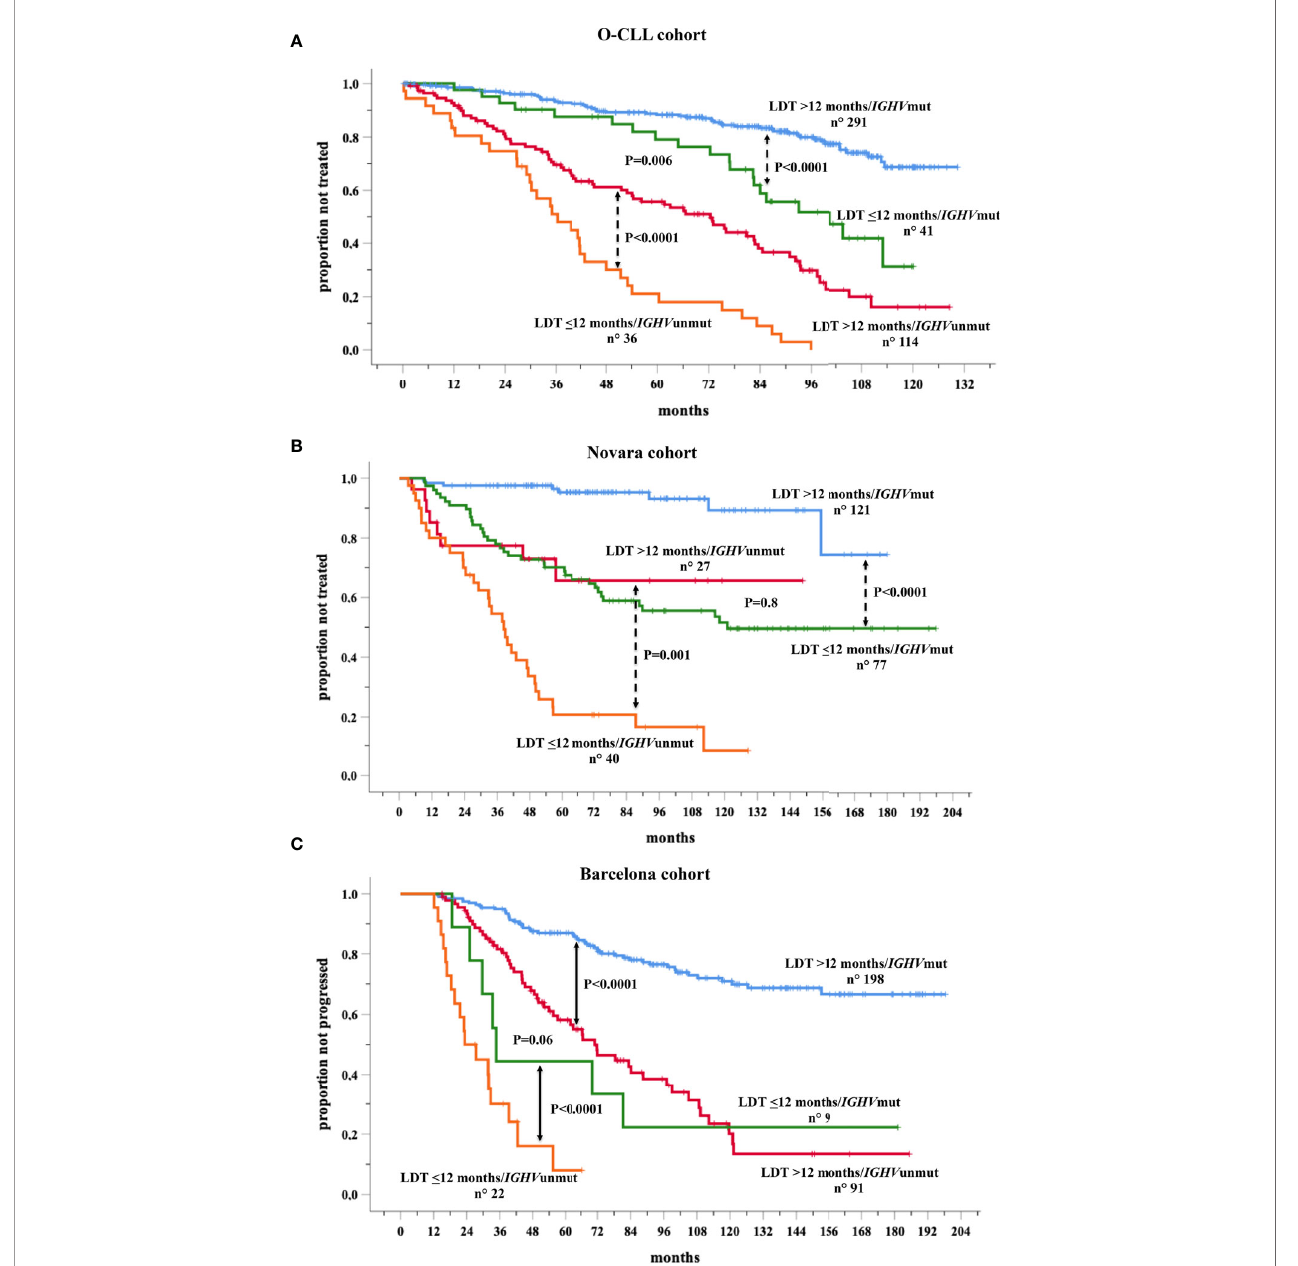
FIGURE 5 | Kaplan-Meir curves of time to fi rst treatment (TTFT) of patients strati fi ed by the combined analysis of lymphocyte doubling time (LDT) and IGHV mutational status in the O-CLL training cohort (A) and Novara (B) and Barcelona (C) validation cohorts for whom both variables were